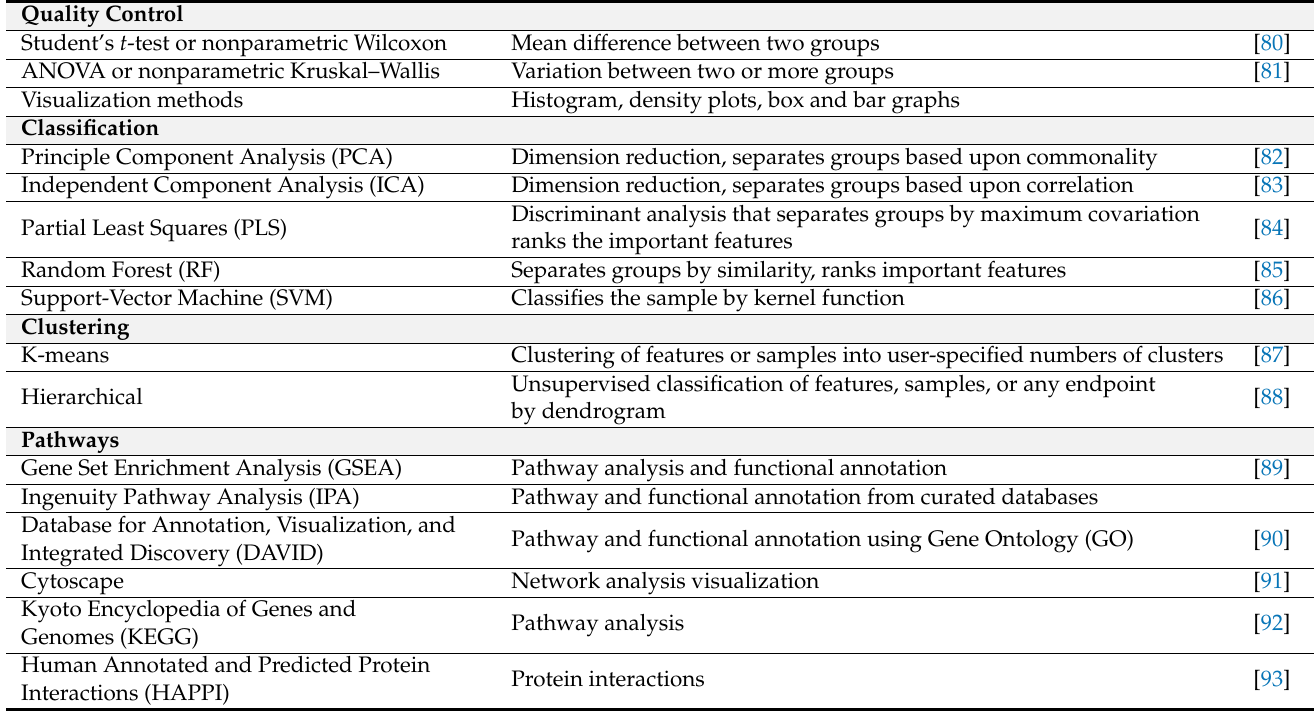
Table 2. Statistical methods for aptamer